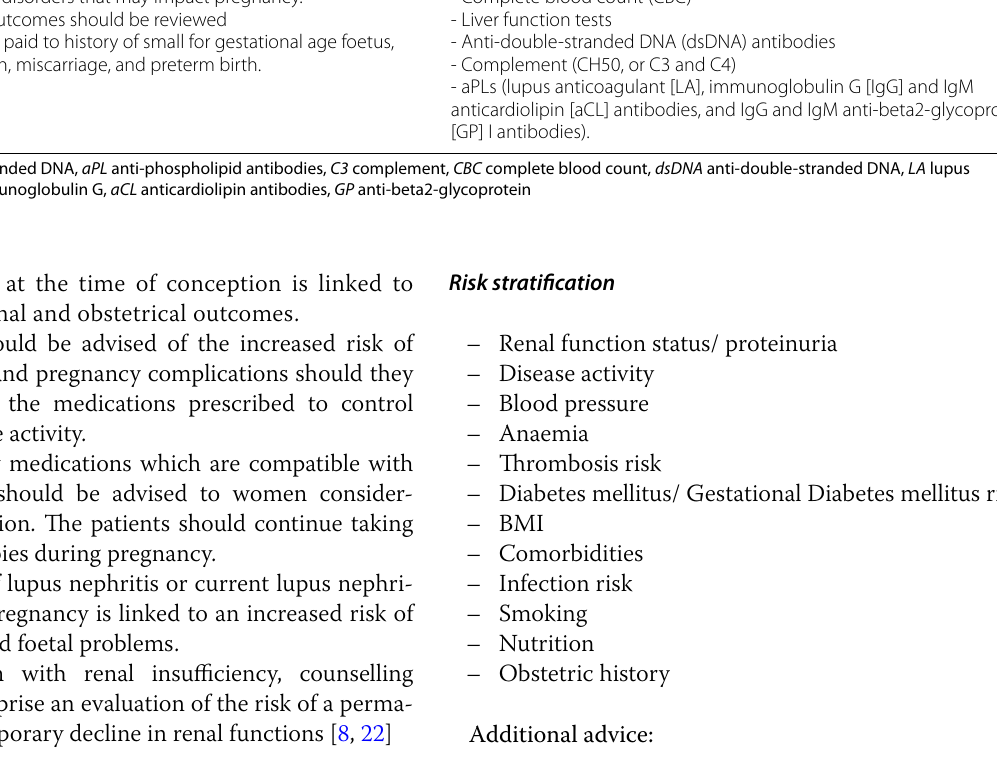
Table 3 Pre‑pregnancy counselling checklist for day‑to‑day standard practice